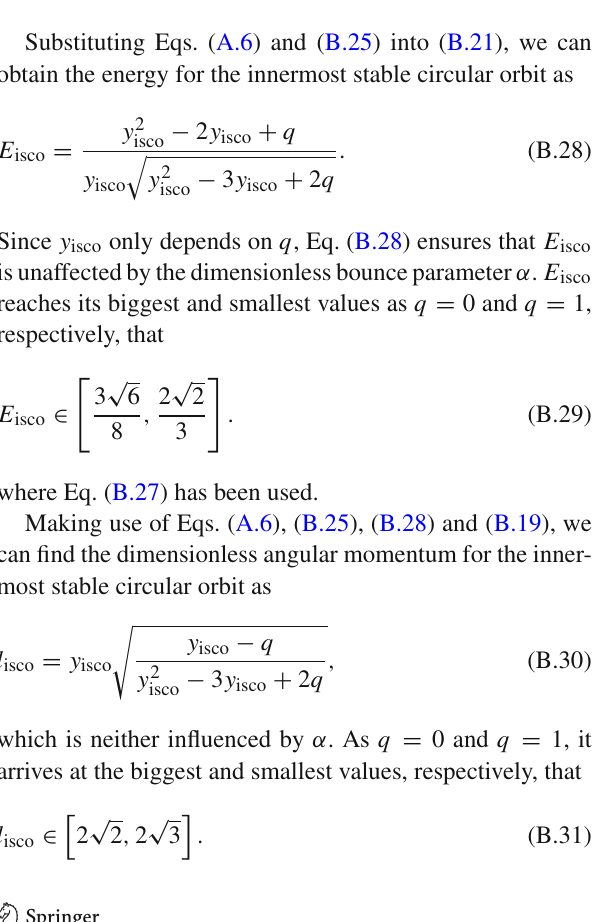
Fig. 8 Curves of N ( y ) with various q against y and the shadowed region represents the unallowed range of y for the innermost stable circular orbit from the condition Eq. (A.7) It clearly shows that y isco is merely determined by the charge q . As q = 0 and q = 1, y isco arrives at its biggest and smallest values, respectively, that y isco ∈ [4 , 6]